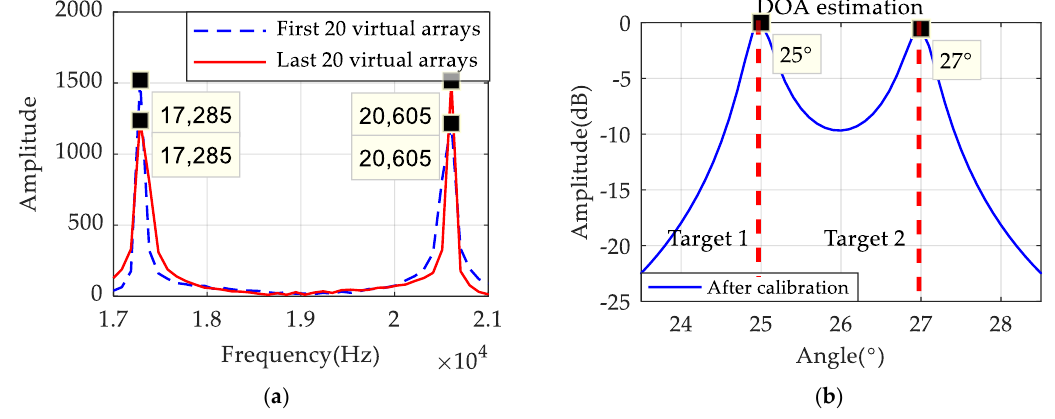
Figure 10. ( a ) The result of FFT after calibration; ( b ) The DOA results after